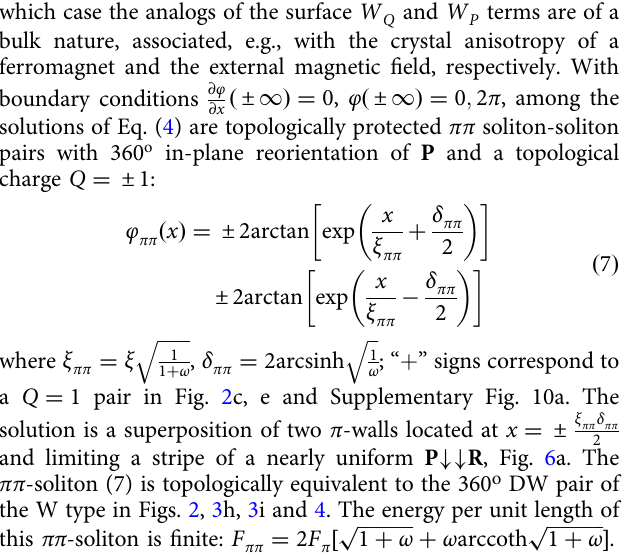
> K and non-planar geometry of the director. K 1 3